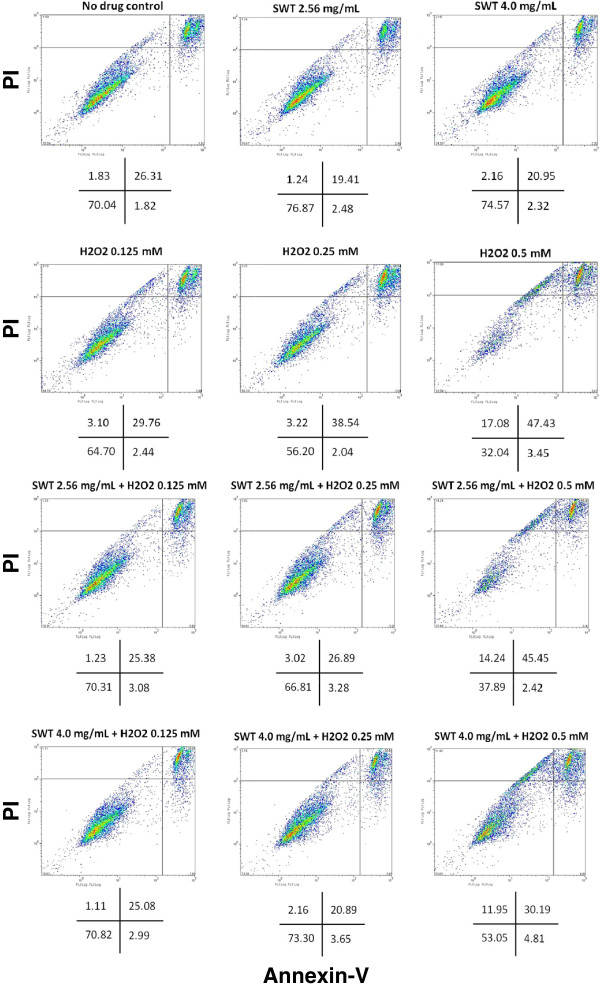
Effects of SWT on H2O2-induced apoptosis in MCF-10A cells. MCF-10A cells (3 × 105 cells/well in a 6-well tissue culture plate) were pre-treated with SWT 2.56 or 4.0 mg/mL for two hour then exposed to 0.125, 0.25 or 0.5 mM of H2O2 for 24 hours. Cells were collected, washed with PBS and resuspended in 1X Annexin V Binding Buffer. Annexin V and/or Propidium iodide (PI) were added to the samples and analyzed by flow cytometry. Flow cytometry profile represents Annexin-V-FITC staining in x axis and PI in y axis. The numbers in each of the quadrant represent the percentage of viable and healthy (lower left), early apoptosis (lower right), necrosis (upper left) and late apoptosis (upper right). The experiment was repeated twice and obtained consistent results.